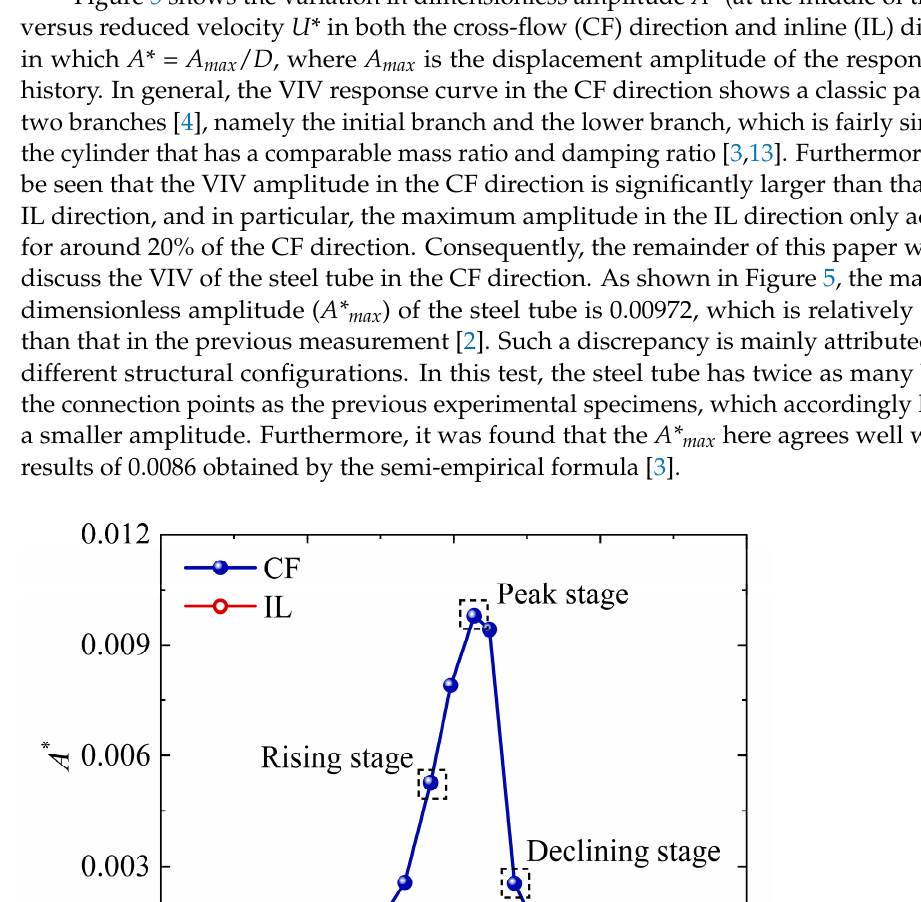
( b ) Figure 4. Definition the yaw angle and yawed steel tubes. ( a ) Definition the yaw angle (top view); ( b ) Yawed steel tubes.